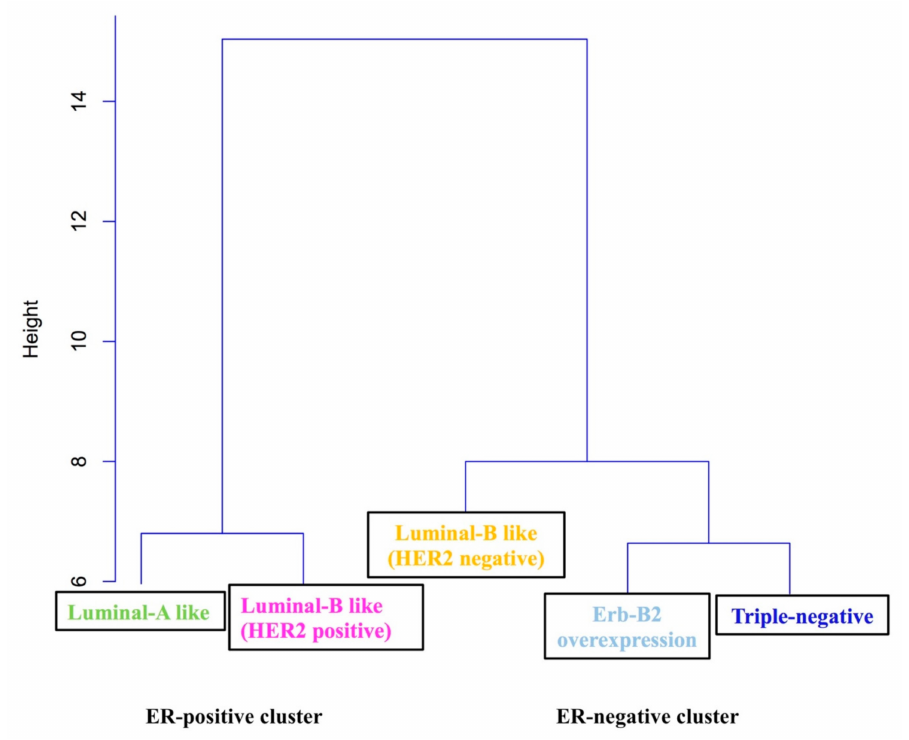
Figure 1. First Cluster Analysis. Abbreviation: HER2: human epidermal growth factor